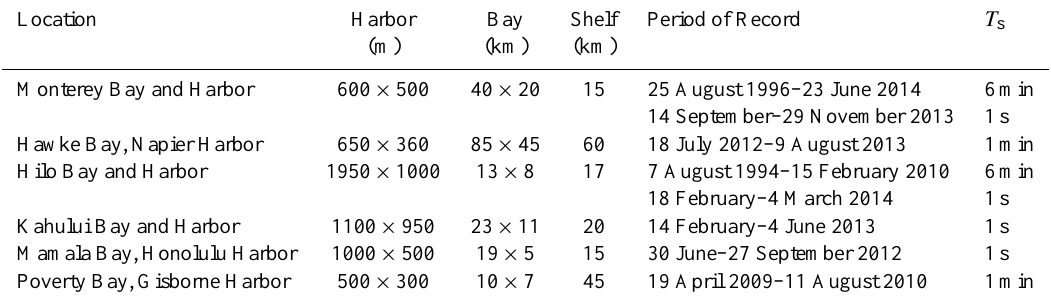
Table 2. Approximate shelf widths and dimensions of bays and harbors, data period of record, and sampling interval T s . Note that data from Hilo and Monterey include both long-period data recorded at T s = 6min and short-period data recorded at T s = 1s. Location Harbor Bay Shelf Period of Record T s (m) (km) (km) Monterey Bay and Harbor 600 × 500 40 ×